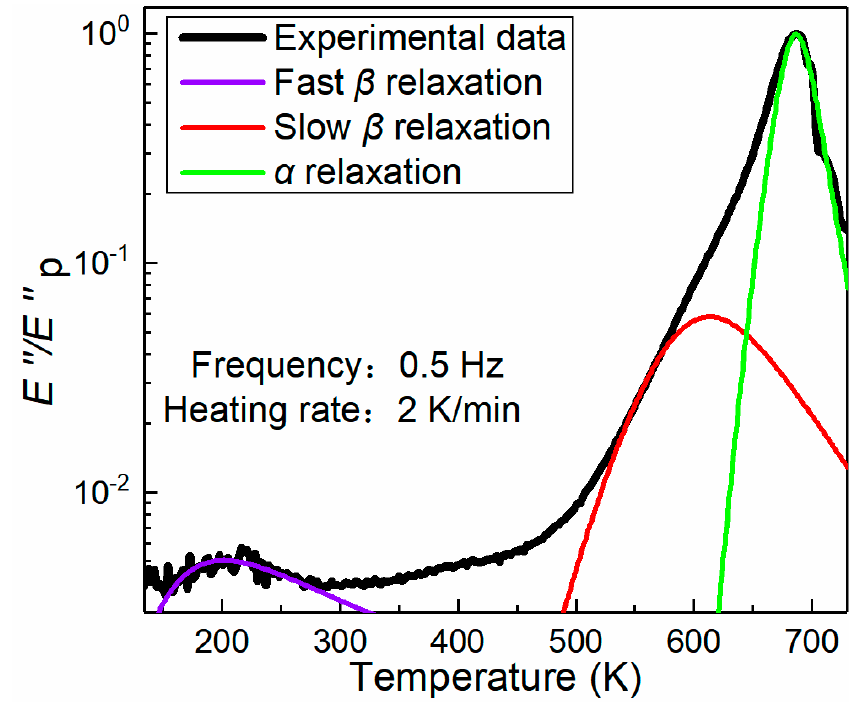
Figure 1. DMA (dynamic mechanical analysis) relaxation spectrum of the BMG (bulk metallic glass). The variation of loss modulus E ″ with temperature were obtained at the frequency of 0.5 Hz and heating rate of 2 K/min. The black line indicates experimental data. The purple, red, and green curves represent the H-N (Havriliak-Negami) fitting of fast β -relaxation, slow β -relaxation, and α -relaxation, respectively (see details of the fittings in [36]).